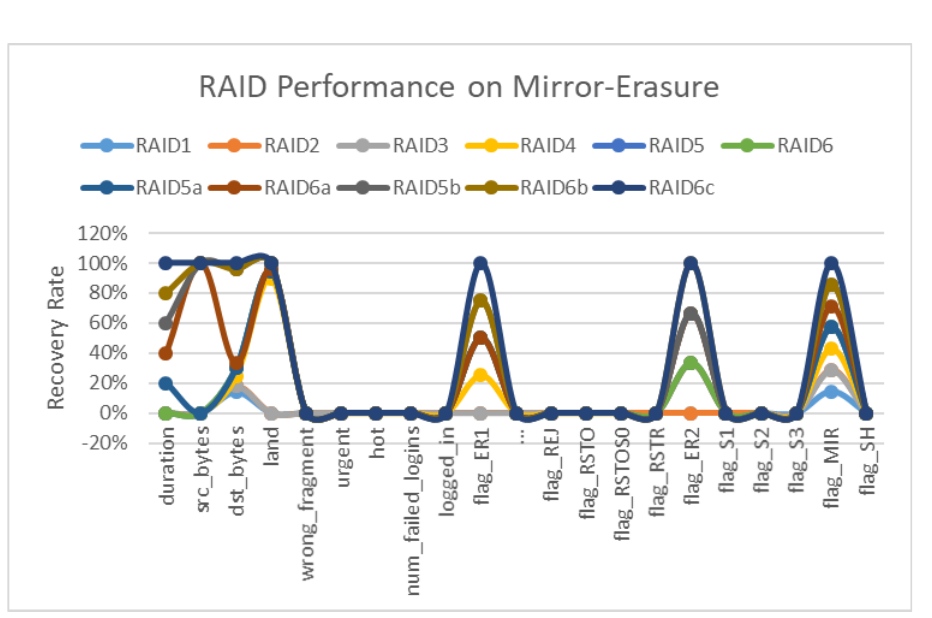
Figure 5. Mirroring and Erasure Coding Graph.